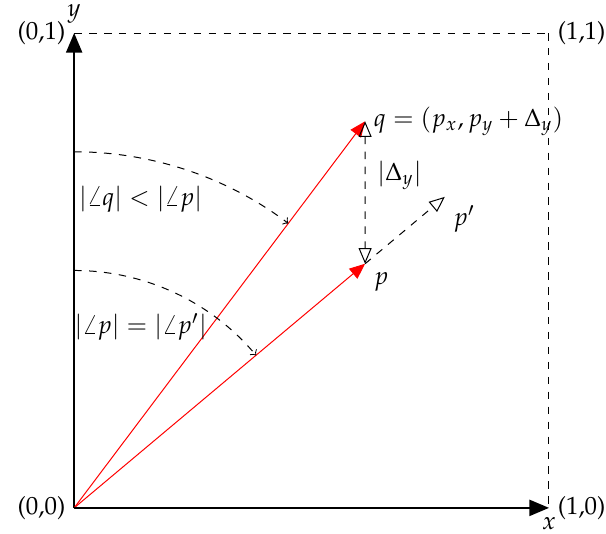
Figure 1. Points p , p (cid:48) and r , in 2-track gain space. Note that the audio output at points p and p (cid:48) is the same ‘mix’.